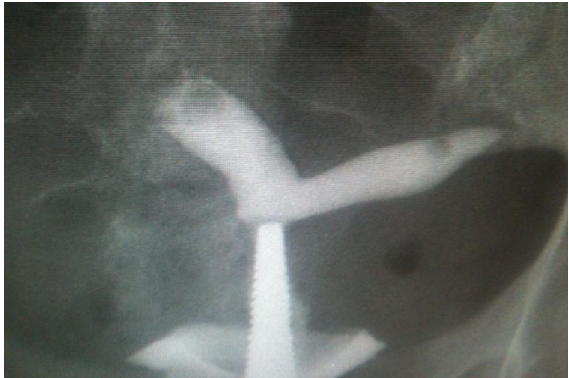
Figure 5: Bicornuate